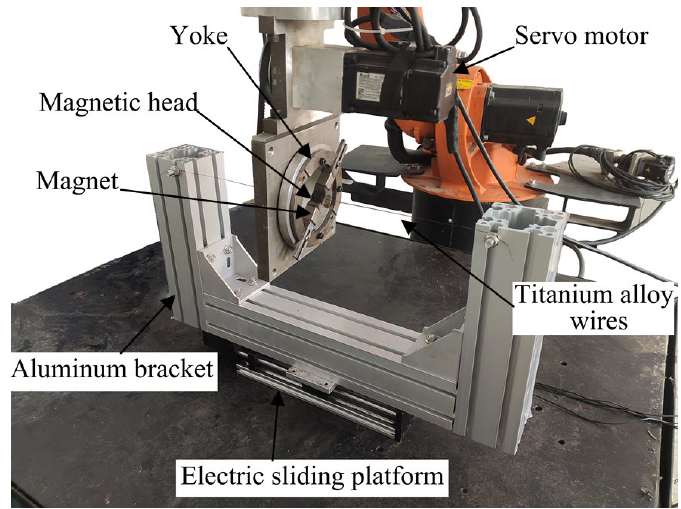
Figure 3. Experimental setup of magnetic abrasive finishing.